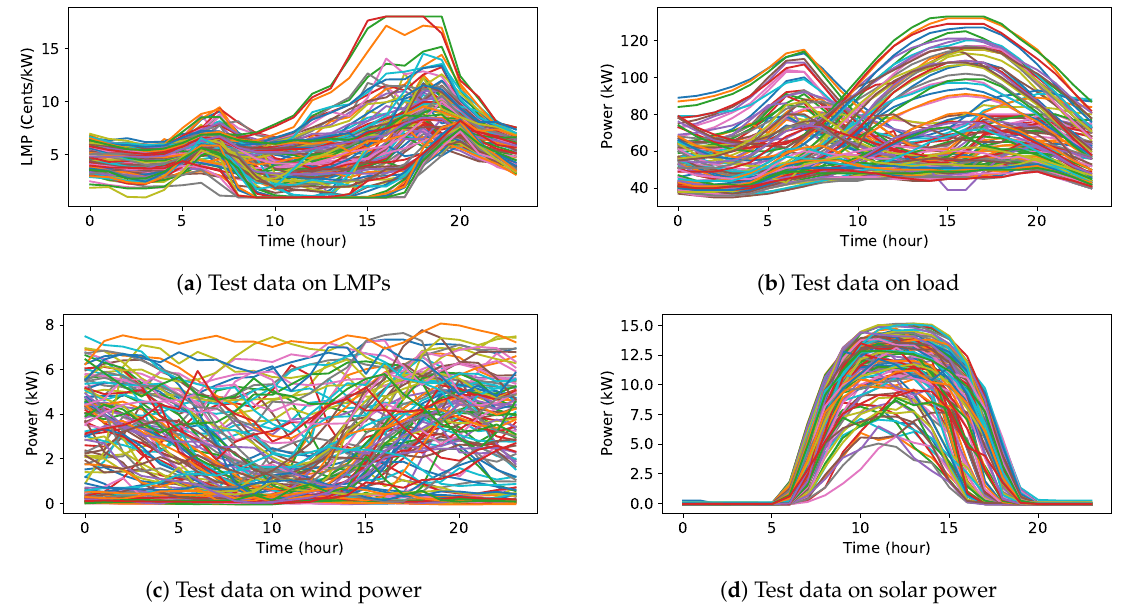
Figure 6. Test data used in the experiment 2. There are 114 days of hourly data in